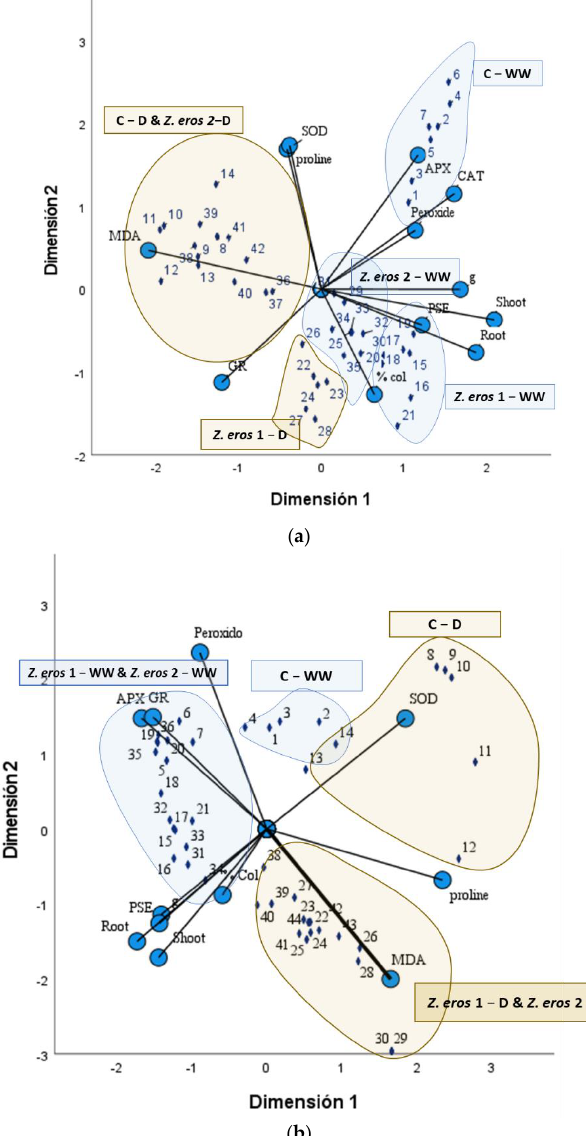
Figure 6. Categorical Principal Component Analysis (CATPCA) of wheat ( a ) and tomato ( b ) plant samples (indicated by dark blue diamonds) measured through antioxidant enzyme activities (SOD, APX, CAT, GR), biochemical analysis (MDA, proline, peroxide), Photosynthetic efficiency (PSE), stomatal conductance (g) and dry weight (shoot and root) (indicated by circle) in two different soil moisture conditions (well-watered conditions (WW) and subjected to drought (D)) and each fungus inoculated H1 or H3. The blue shading shows the distribution of the WW samples and the yellow shading shows the D.